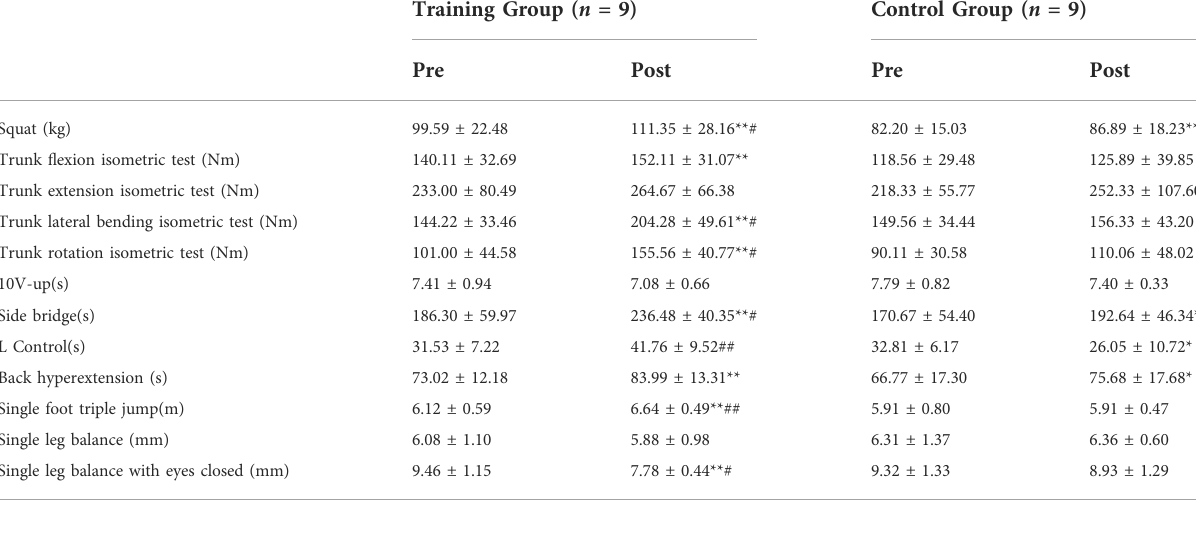
TABLE 3 Performance in core stability results (Mean ± SD).